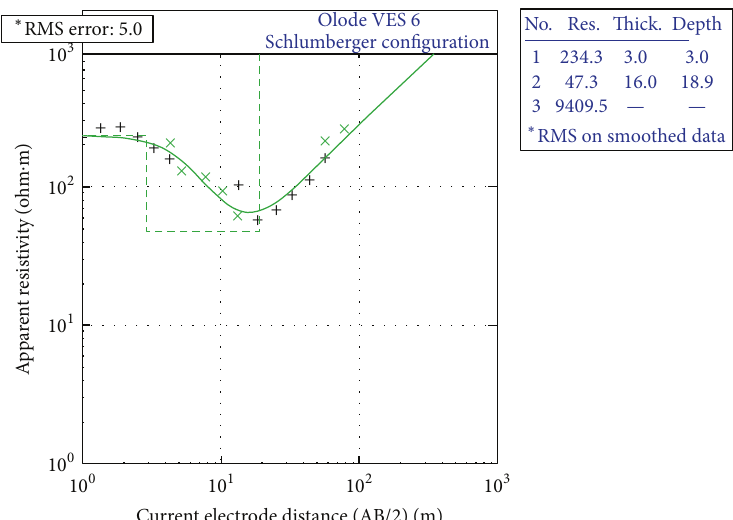
Figure 18: Sounding curve of VES